Question: Compose a caption that would accompany this figure in a paper.
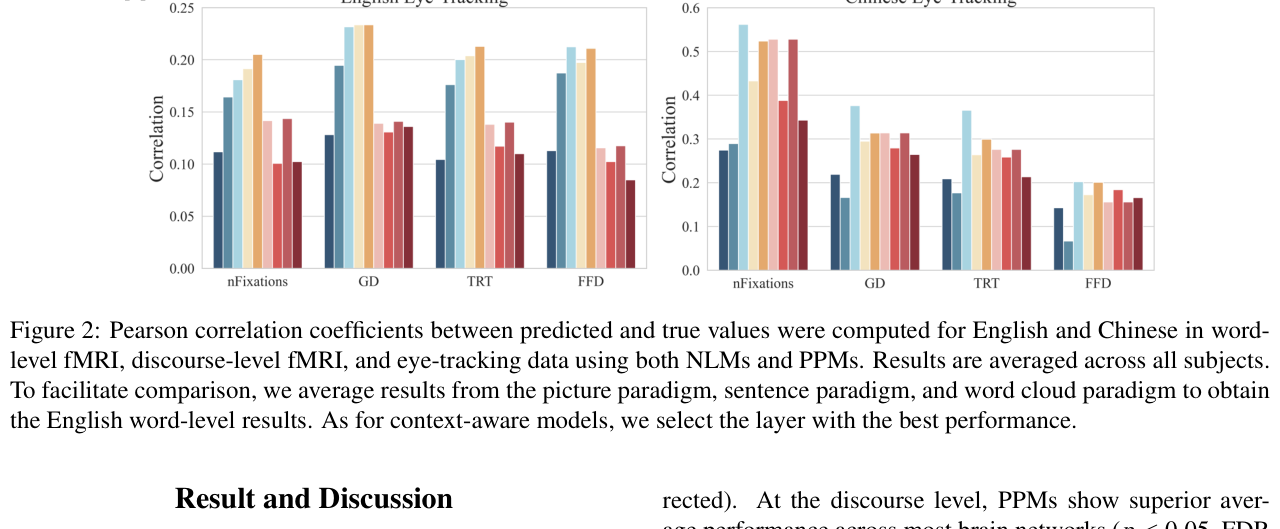
Answer: illustrates the mean encoding performance of NLMs and PPMs across subjects for selected brain networks in Chi- nese and English, covering word-level fMRI, discourse-level fMRI and eye-tracking data. Figure 3 displays the mean per- formance of each layer within context-aware models across whole brain for both Chinese and English in word-level and discourse-level fMRI. Figure 4 shows distribution of top- performing model for each voxel across whole brain.